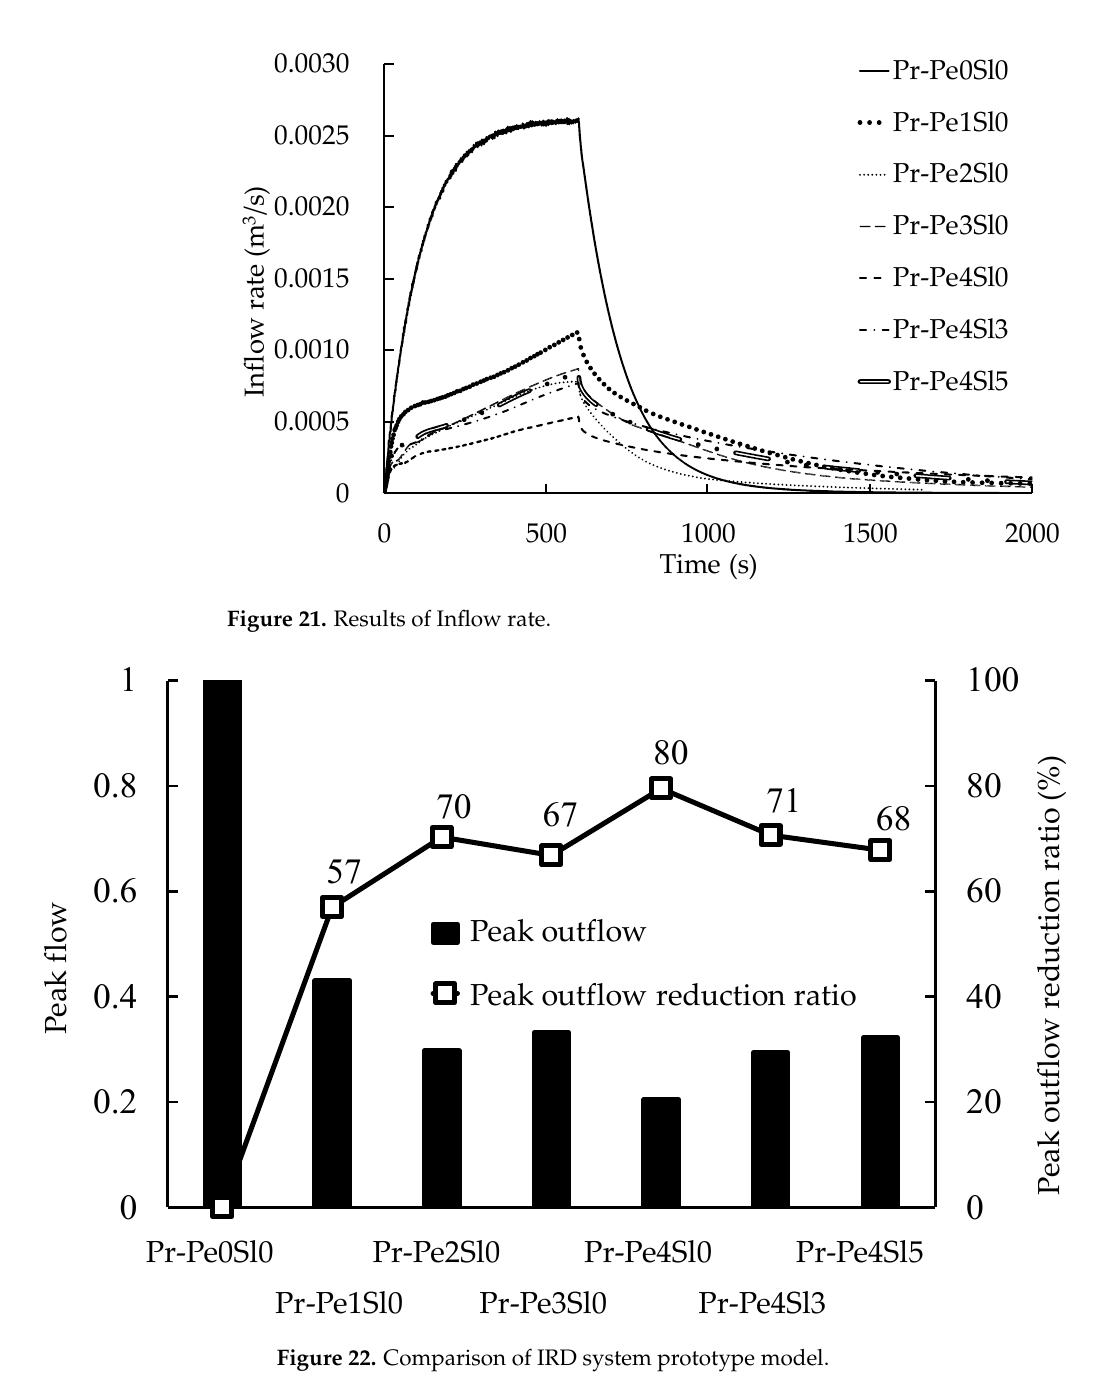
Figure 22. Comparison of IRD system prototype model.